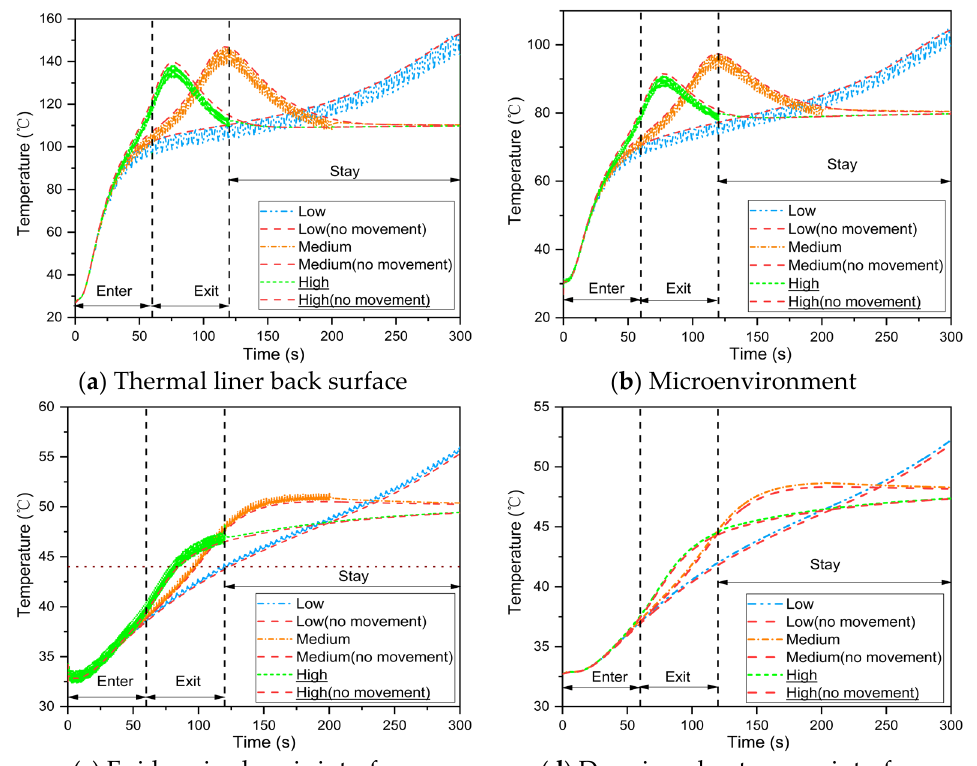
Figure 13. Effect of human body movement speed on the temperature distribution in the skin–microenvironment–fabric system.